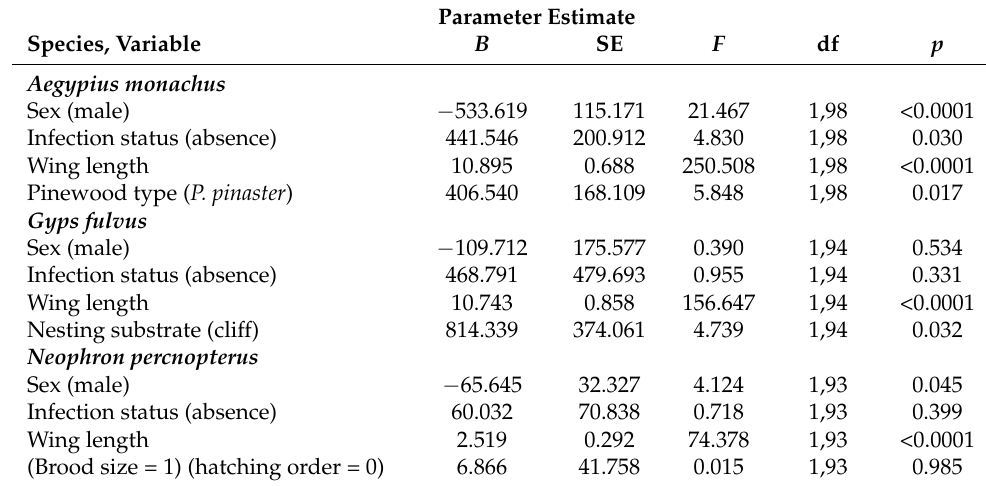
Table 2. Generalized linear models (GLMs) of body mass of nestlings of three vulture species sam- pled in central Spain. Parameter estimates for the levels of fixed factor and their standard errors were calculated considering the category of reference indicated in parentheses.